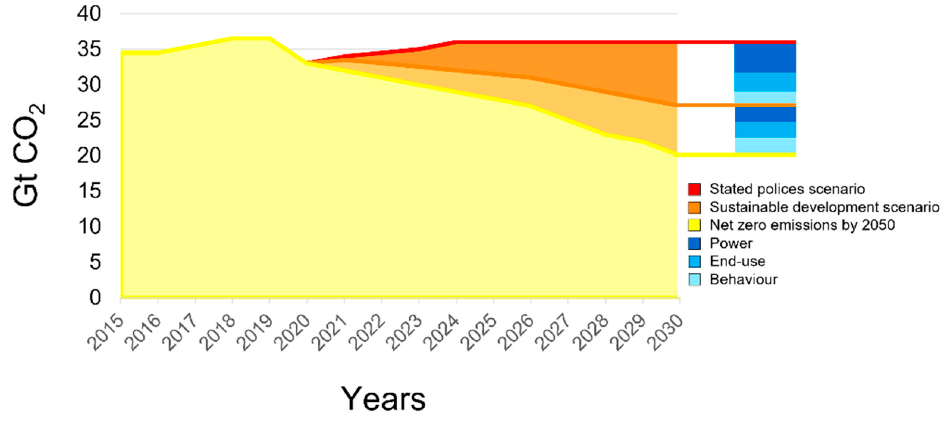
Figure 1. CO 2 emissions and forecasting of reduction levels (adapted from [6]).